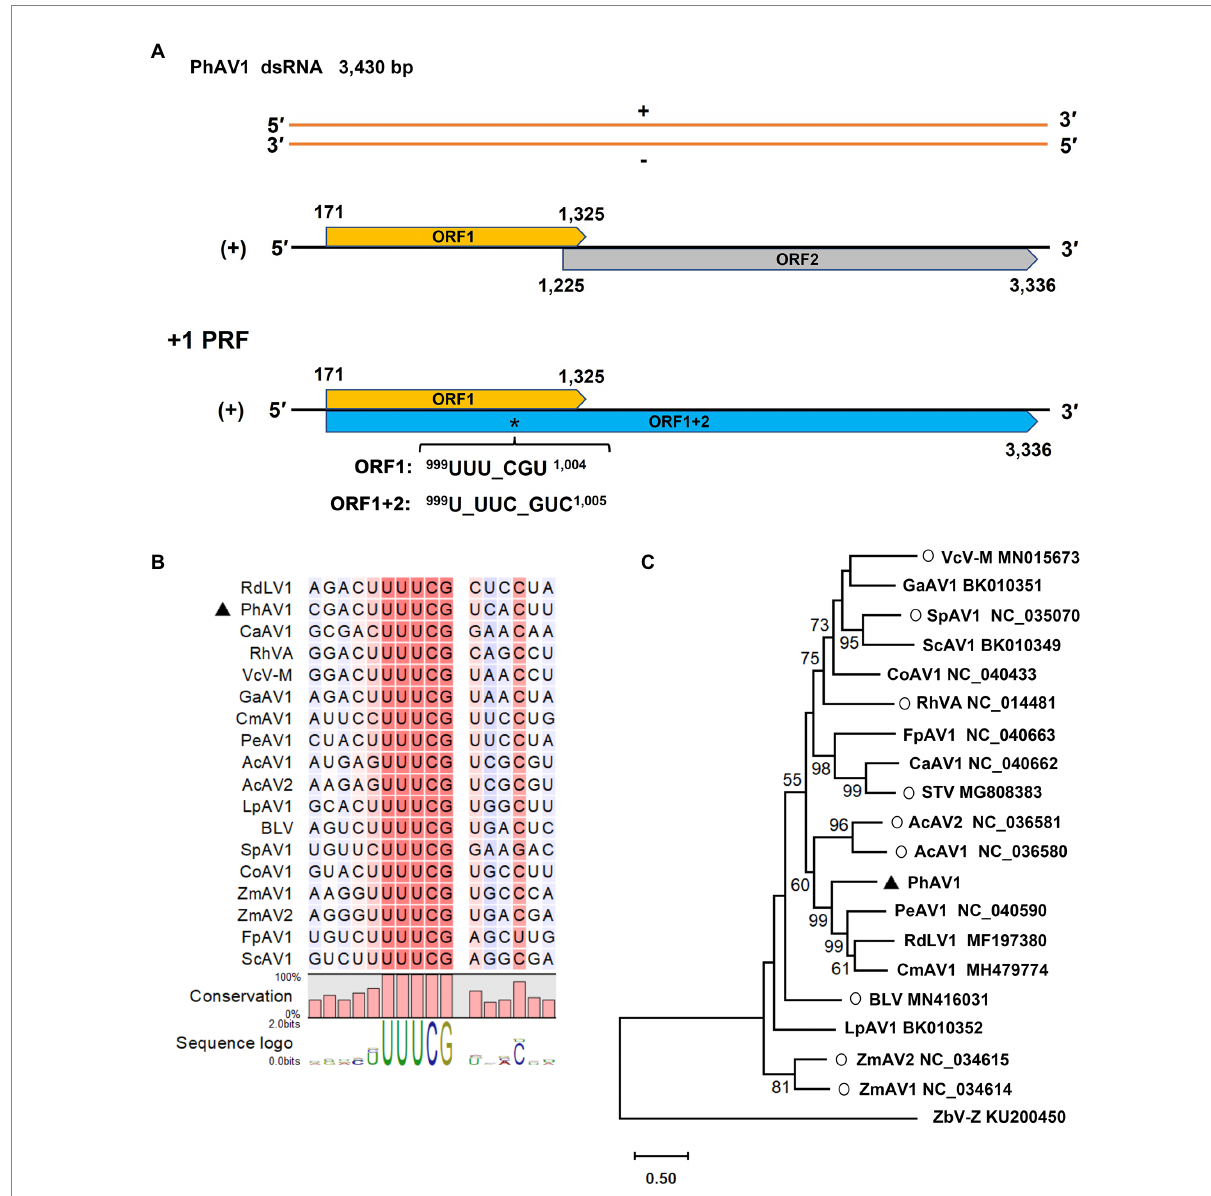
FIGURE 6 Characterization of a novel amalgavirus, pseudostellaria heterophylla amalgavirus 1 (PhAV1), isolated from Pseudostellaria heterophylla in China. Genomic organization of PhAV1 (A) , and the putative + 1 programmed ribosomal frameshifting (PRF) motif of PhAV1 (B) . (C) A phylogenetic analysis based on the amino acid sequences of the RNA-dependent RNA polymerase (RdRp) of PhAV1, nine confirmed (marked with a circle) and nine putative species in the genus Amalgavirus , performed by the maximum-likelihood method in MEGA X. The black triangle represents the novel amalgavirus identified in this